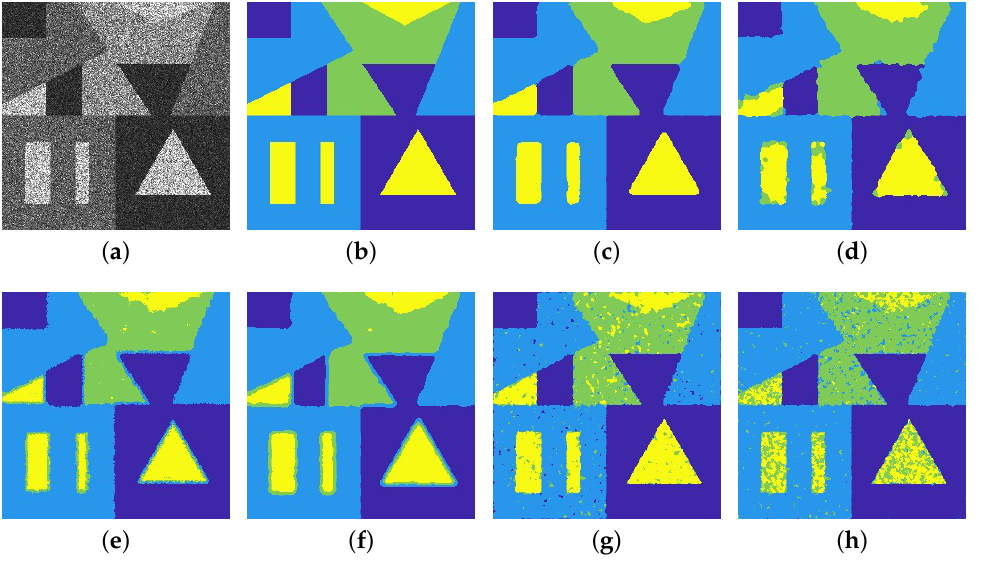
Figure 13. Segmentation results: ( a ) experimental image, ( b ) ground truth, ( c ) proposed, ( d ) FKPFCM [29], ( e ) NSFCM [1], ( f ) ILKFCM [28], ( g ) ALFCM [31], ( h ) CKSFCM